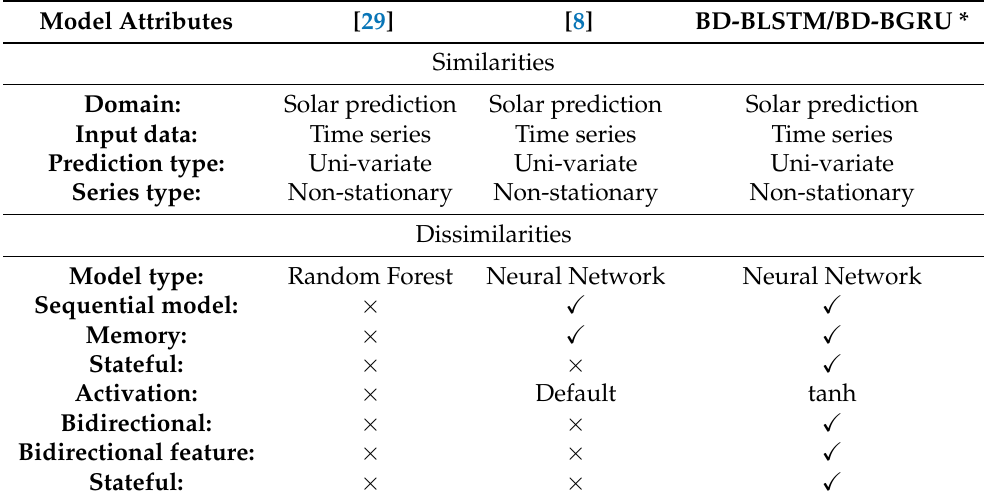
Table 5. Architectural similarity and dissimilarity of the proposed model compared to the refer- ence models. Model